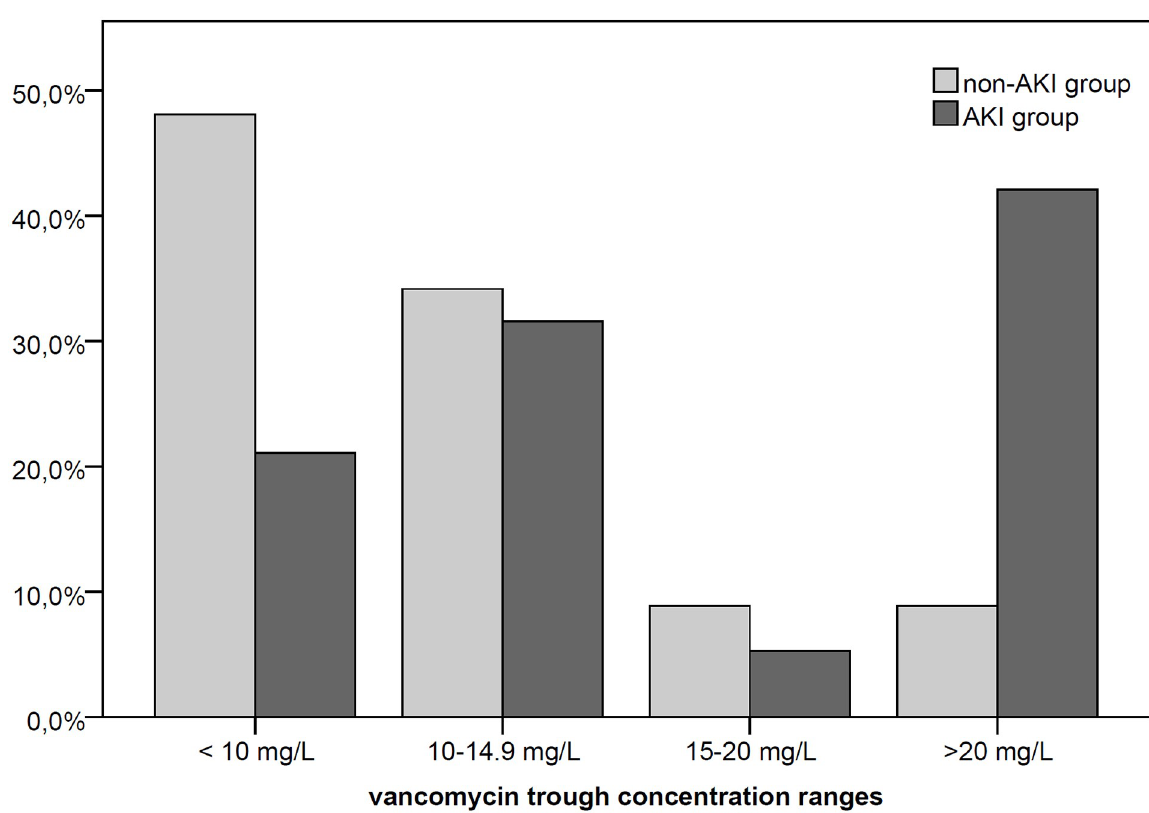
Fig 2. Comparative analysis of initial vancomycin trough levels according development of AKI. AKI, acute kidney injury.